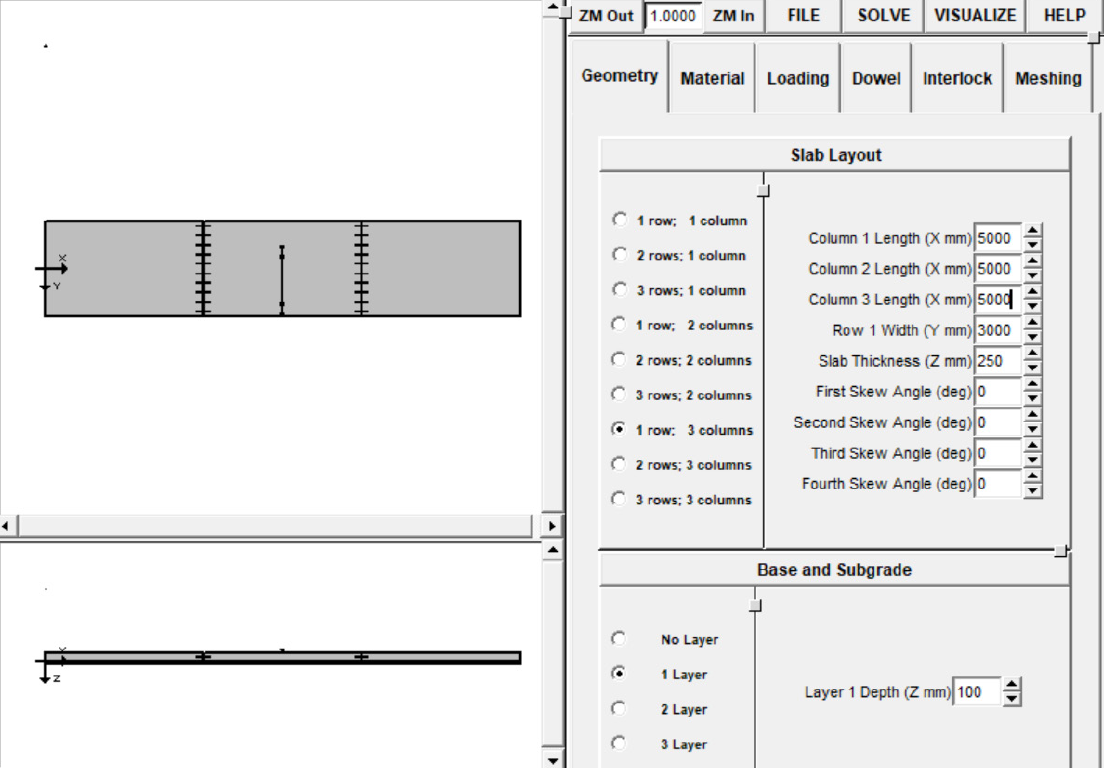
Figure 2. Example of the graphic int erface in the software EverFE